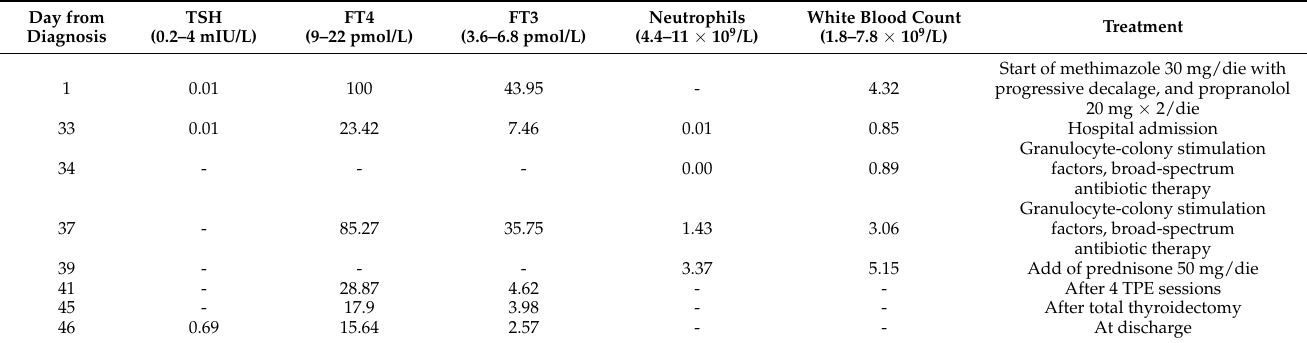
Table 2. Thyroid hormone status from the diagnosis in patient